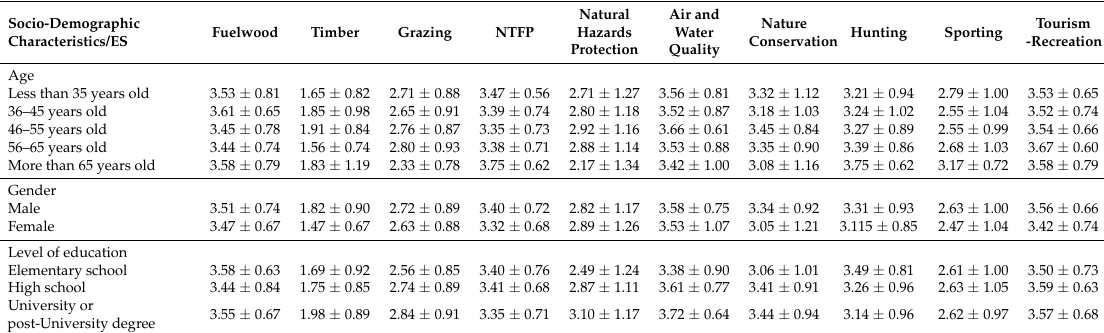
Table 5. Stakeholders’ preferences for ten ES by socio-demographic characteristics of respondents (mean value).